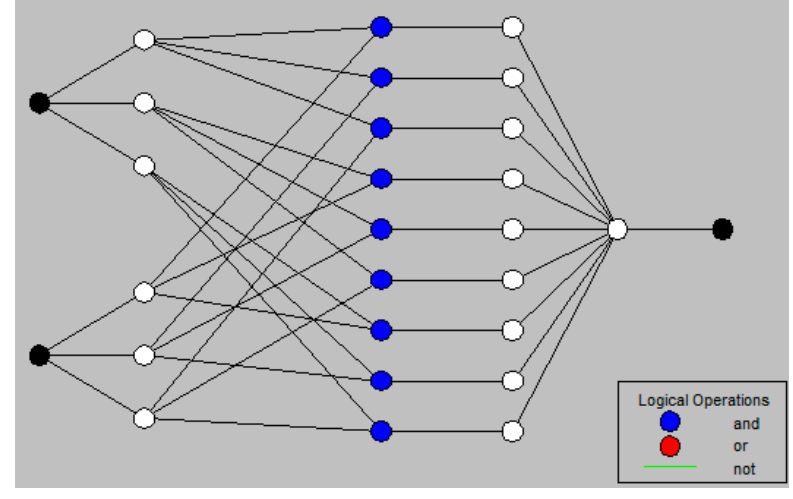
Figure 12. Structure of adaptive neuro-fuzzy inference system (ANFIS).